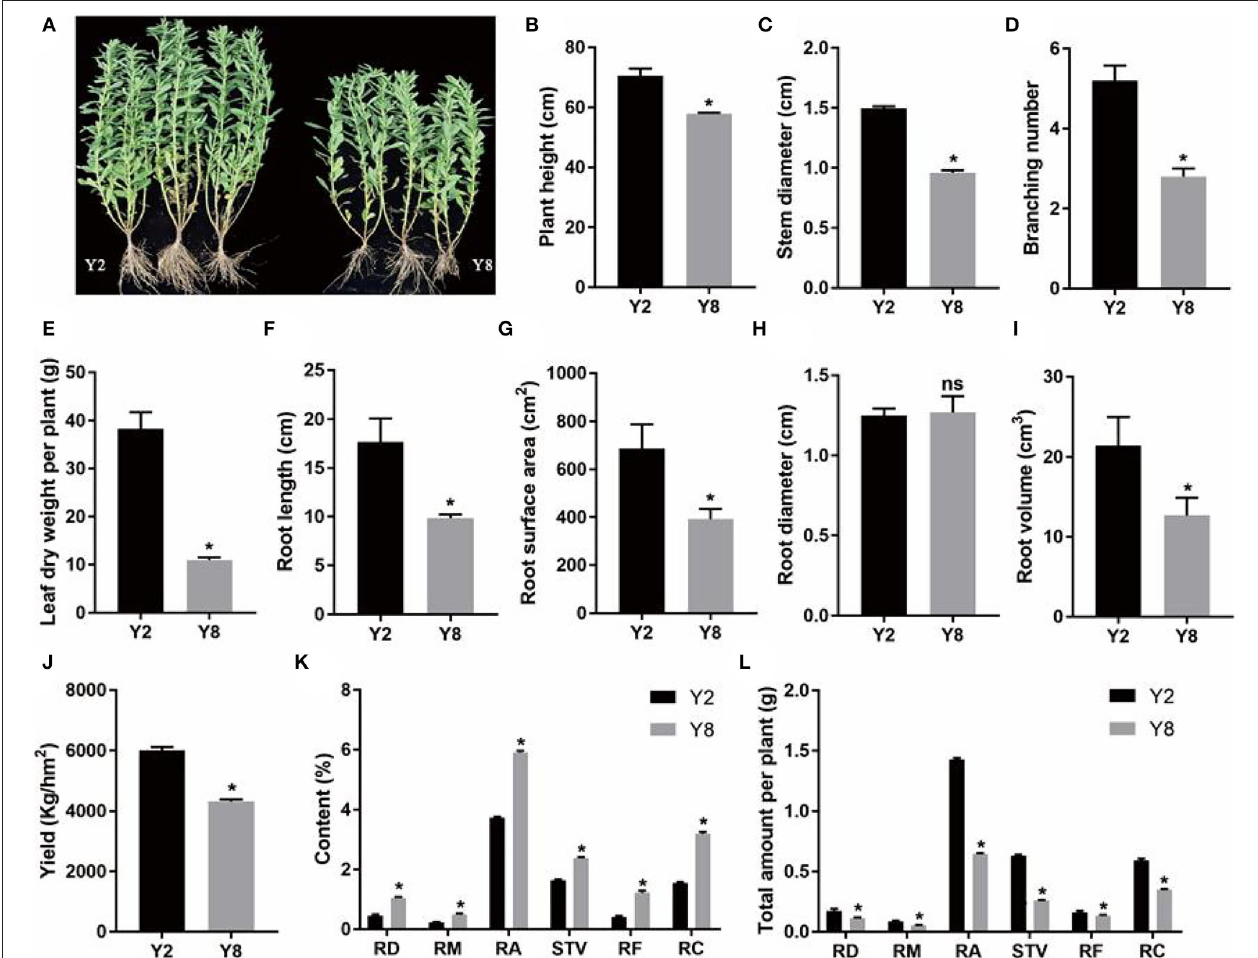
FIGURE 1 | The characteristics and comparison of plant growth and the content of steviol glycoside (SVgly) content between 2 years of continuous cropping (Y2) and 8 years of continuous cropping (Y8). (A) Stevia plants grow after Y2 and Y8, respectively. (B) Plant height. (C) Stem diameter. (D) Branching number. (E) Leaf dry weight per plant. (F) Root length. (G) Root surface area. (H) Root diameter. (I) Root volume. (J) Yield. (K) The content of SVglys. (L) The total amount of SVglys per plant. The total amount of SVglys per plant was based on results of dry leaf weight per plant and the content of SVglys. RD, RM, RA, RF, RC, and STV